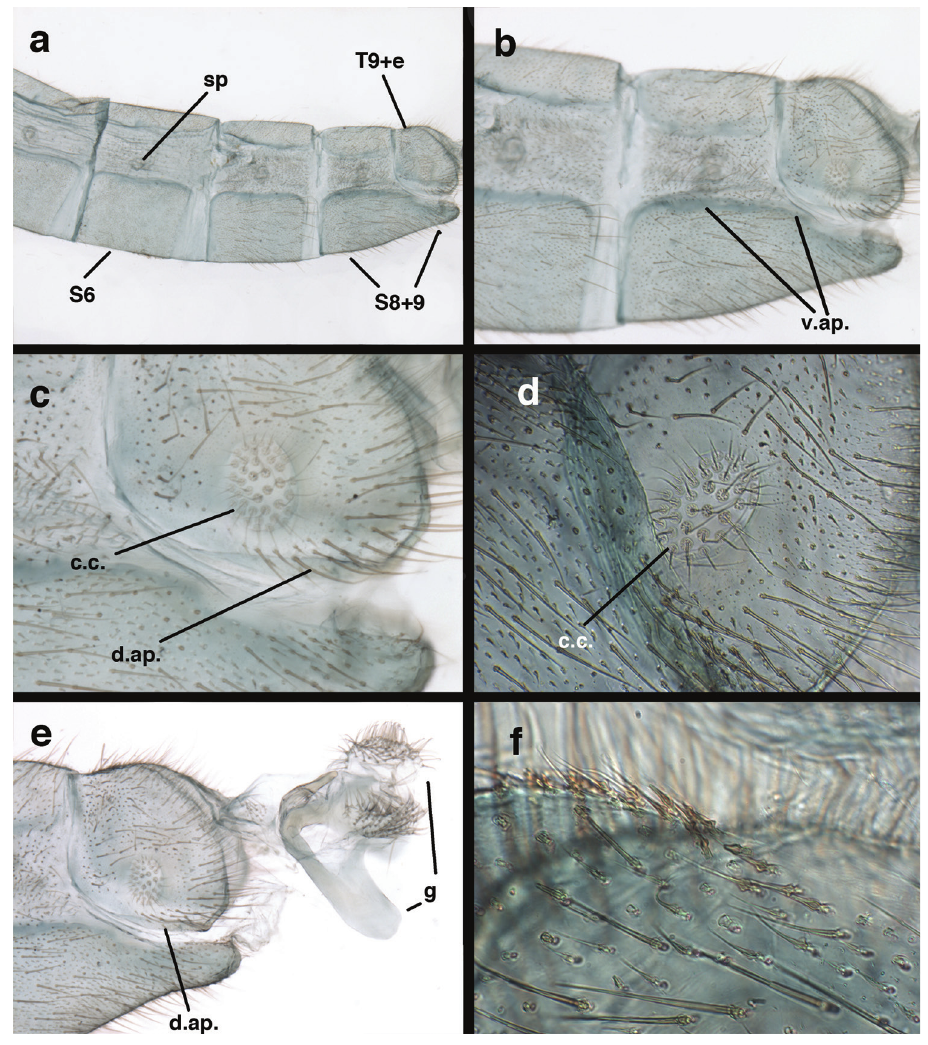
Figure 13. Ungla banksi Tauber, new replacement name: Male abdomen, ( a ) segments A6-terminus, lateral [Note slightly enlarged spiracles.] ( b ) terminalia, lateral ( c ) tip of tergite 9+ectoproct, lateral ( d ) callus cerci ( e ) tip of abdomen with gonarcal complex everted ( f ) flanged setae at tip of S9. c.c. callus cerci d.ap. apodeme on ventral margin of T9+ectoproct g gonarcus sp spiracle S6 sixth sternite S8+9 fused eighth and ninth ster- nites T9+e fused ninth tergite and ectoproct v. ap. ventral apodeme (Bolivia, Rio Zongo, holotype, MCZ).